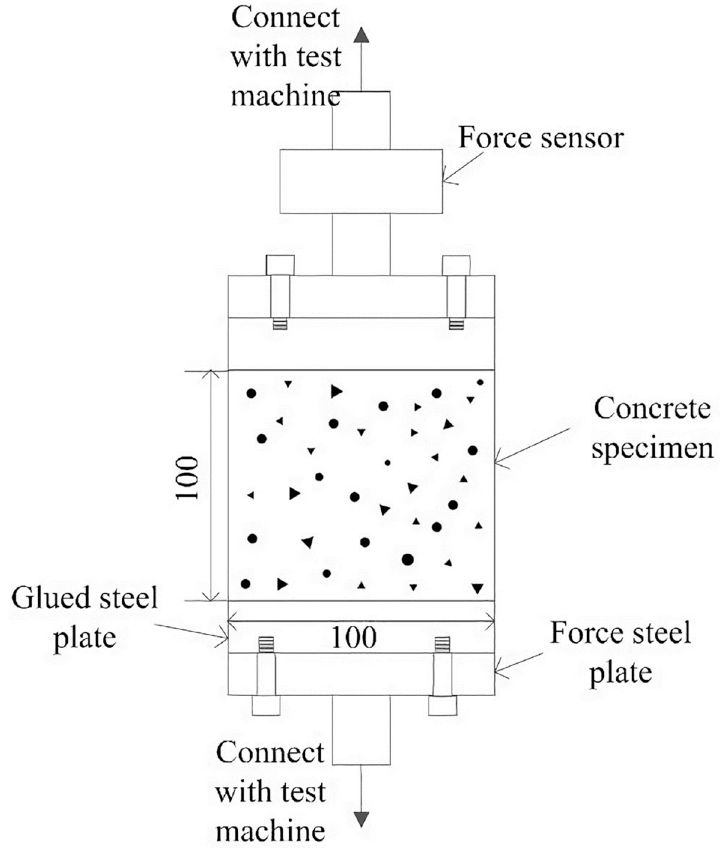
Fig 7. Glued double-plated concrete uniaxial tensile test device [31]. The tensile stress on the bonding interface is regarded as uniform distribution in this device.